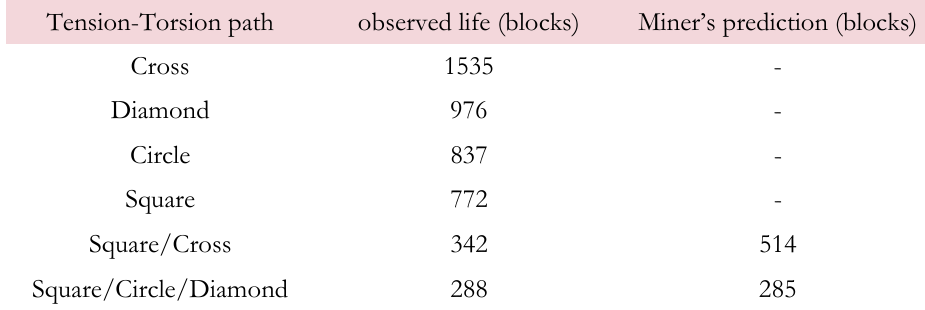
Table 1: Observed initiation lives, in number of blocks, for each applied tension-torsion path, and Miner’s